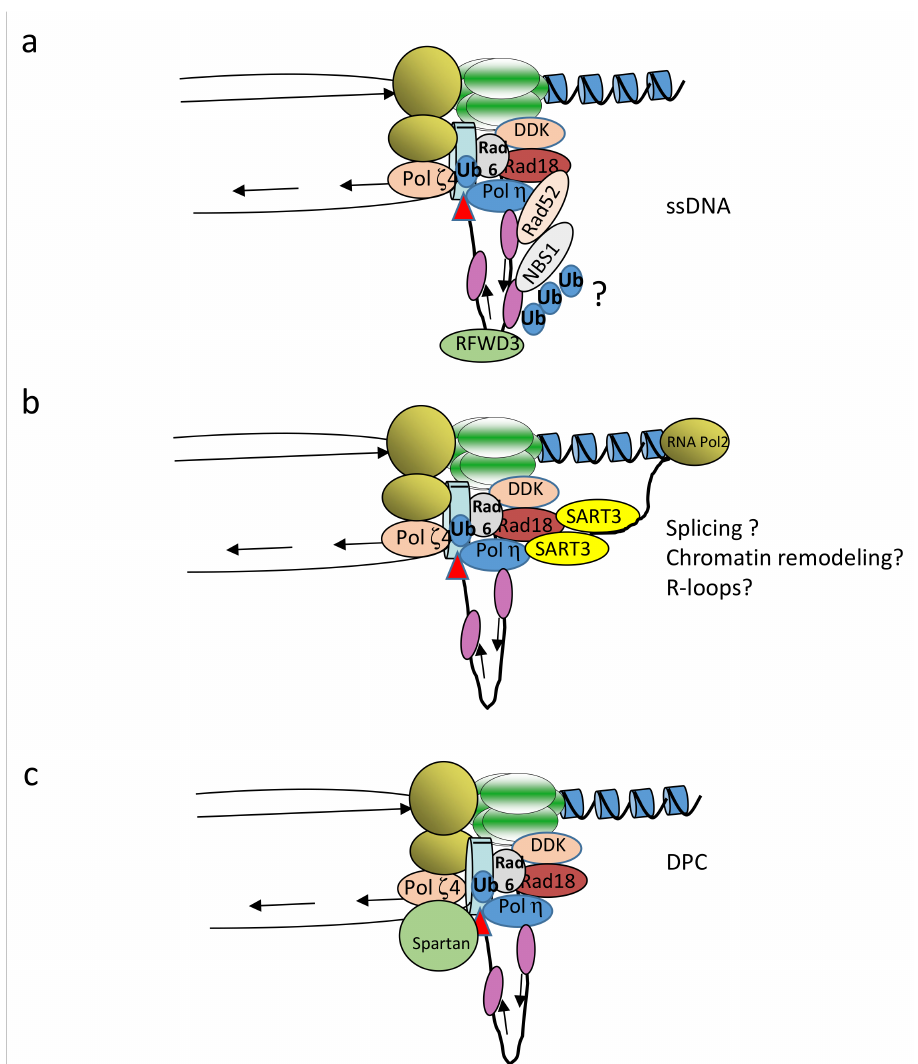
Figure 2. Speculative model of translesion synthesis (TLS) pol recruitment at replication forks stalled by DNA distorting lesions. ( a ) When the replisome encounters DNA distorting lesions (red triangles), replicative polymerases (Pol α , δ , ε ) are stalled, while the replicative helicase (CMG complex) can slide through. This process generates an excess of ssDNA ( b ). Discontinuous DNA synthesis continues on the lagging strand, which generates small replication intermediates that prime the recruitment of specific checkpoint factors leading to activation of the ATR-dependent checkpoint (DDR, not shown). TLS Pol κ is recruited onto these replication intermediates to stabilize them and facilitate ATR signaling through Chk1 phosphorylation [38]. DDR activation activates the CRL4 Cdt2 ubiquitin ligase, which induces PCNA-dependent PIP degron-containing proteins destruction, such as the p12 subunit of the Pol δ holoenzyme. This process facilitates Pol ζ 4 complex recruitment into the Pol δ holoenzyme to position it for bypass extension. Recruitment of RPA onto ssDNA brings about Primpol and other factors (see Figure 1). Primpol allows repriming on the leading strand. Rad18 binding is also stabilized by interaction with Pol η and DDK. The Rad6/Rad18 complex then catalyzes PCNA mUb , thus stabilizing interaction of Pol η (and/or other Y-family TLS pols) with PCNA. Pol η poly-SUMO modification by PIAS1 and PCNA ISGYlation by the ISG15 (E3) ligase EPF also occurs at this stage. Following this step, the lesion is b-bypassed by the sequential action of Pol η and Pol ζ (insertion and extension, respectively). Upon lesion bypass, Pol η is polyubiquitinated by CRL4 Cdt2 , OGTylated, and extracted from chromatin by the p97/VPC/Segregase complex to be targeted for proteasomal degradation, while PCNA is deubiquitinated by the concerted action of USP1 and USP10, thus leading to disassembly of the TLS complex including Rad18 ( c ). The Ubr5 ubiquitin ligase is also implicated in this step by mediating Pol η chromatin binding through the ubiquitination of histone H2B [39]. Finally, inactivation of CRL4 Cdt2 and stabilization of the ubiquitin hydrolase USP1 resets PCNA, to a DNA replication-competent form followed by TLS Pol degradation and/or release, thus allowing fork